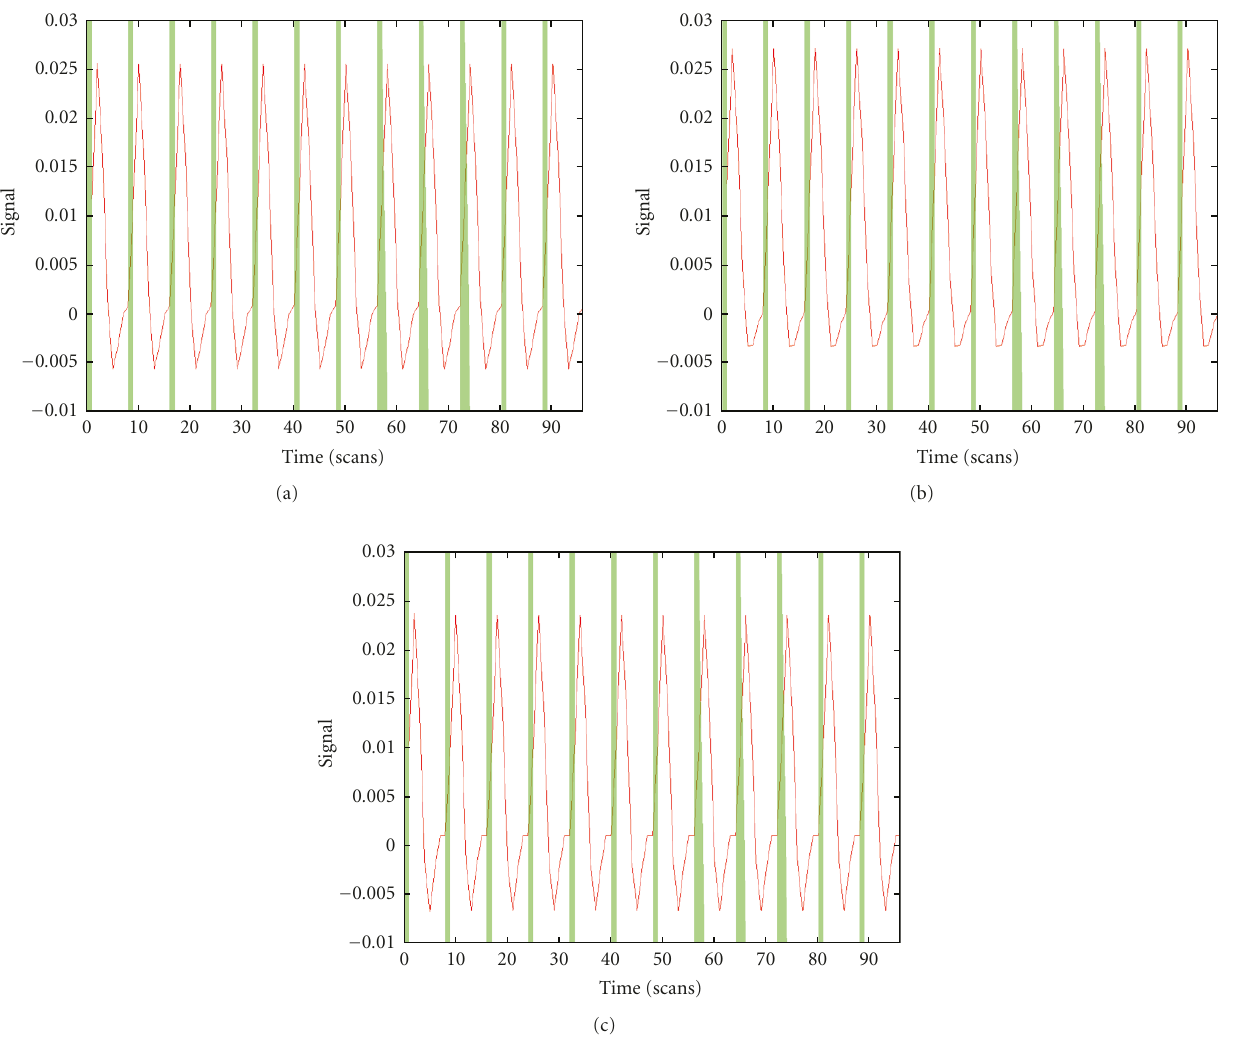
Figure 3: Simulated Datasets with three parameter sets. Each stimulus event, which was simulated by rectangular pulse of width 2-seconds.